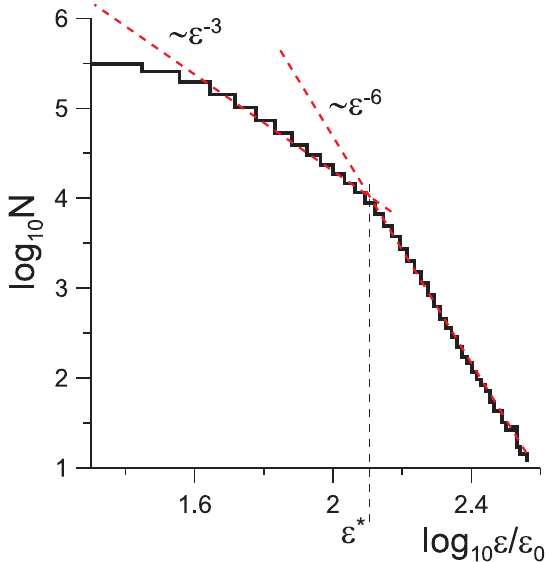
Fig. 6. Energy distribution of particles in the system with v D = 0 . 025, w D = 0 .